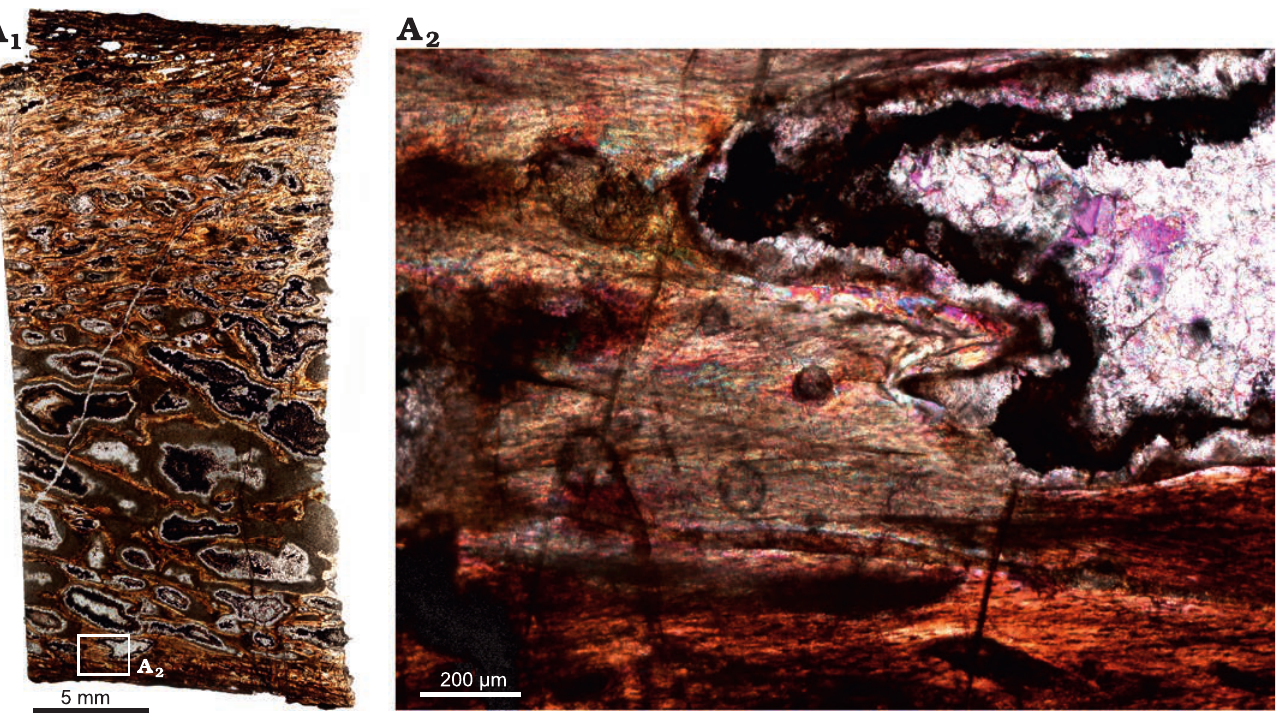
Fig. 6. Longitudinal section of the rib (BP/1/5409) of cf. Jonkeria sp. from the middle Permian Tapinocephalus Assemblage Zone of the Karoo Basin of South Africa. A 1 , overall view of the rib showing highly secondarily remodeled cortex; note: numerous enlarged resorption cavities. A 2 , detail showing woven bone and enlarged resorption spaces. Photographs under ordinary light (A 1 ) and cross-polarized light with lambda compensator (A 2